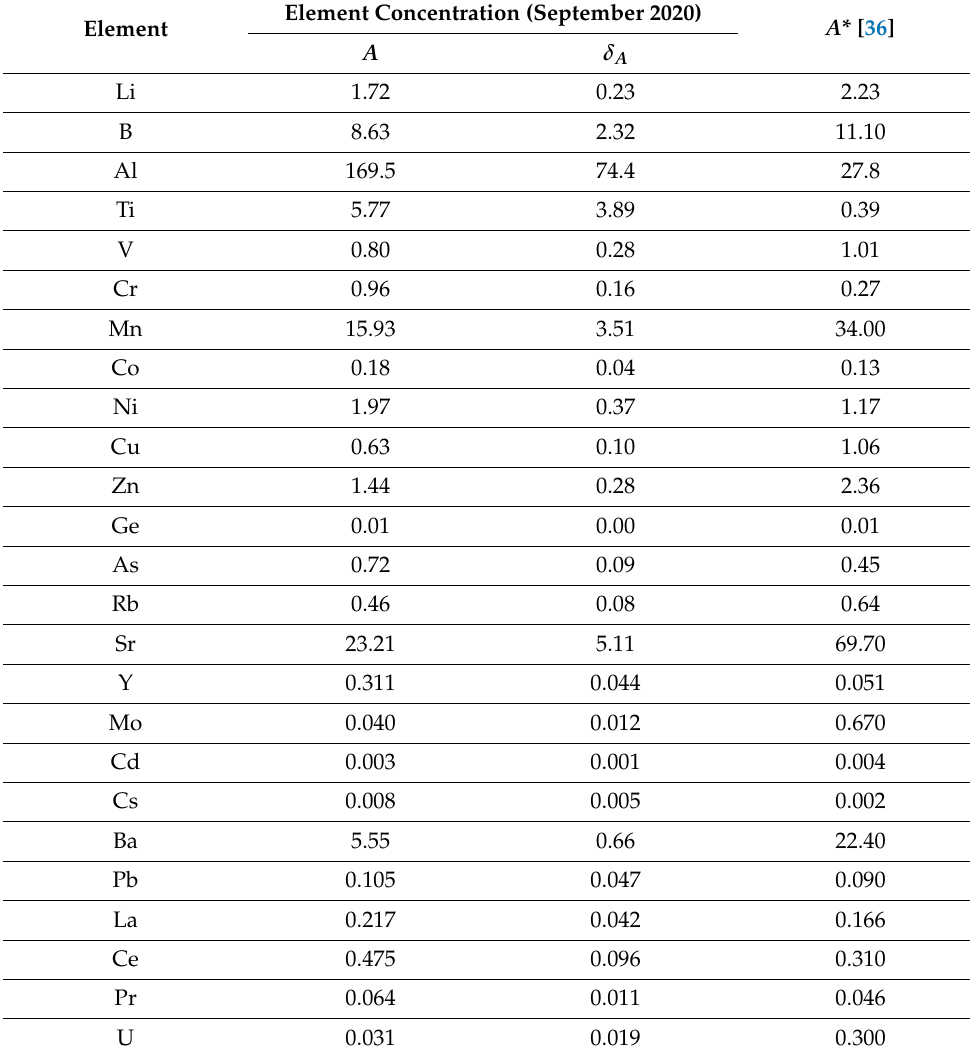
Table 4. Average values of trace elements in rivers of the Kara basin, sampled in September 2020, µ g/L.